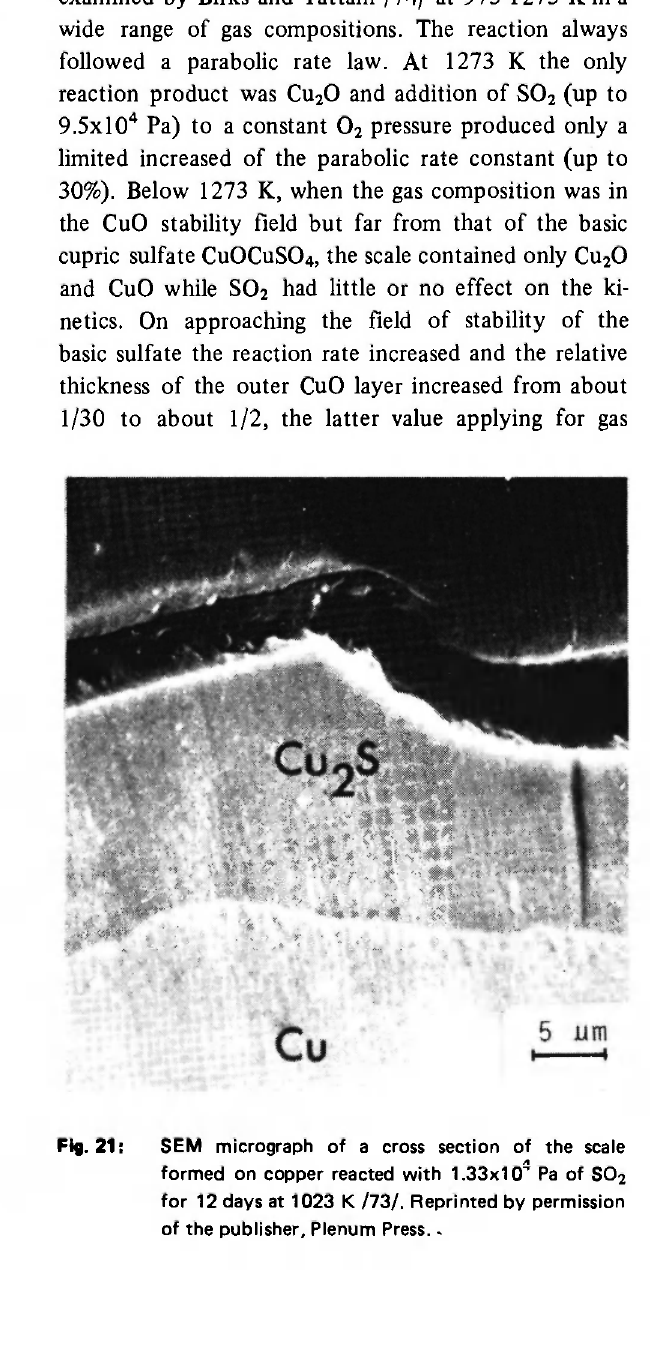
SEM micrograph of a cross section of the scale formed on copper reacted with 1.33x10 Pa of S0 2 for 12 days at 1023 Κ /73/. Reprinted by permission of the publisher. Plenum Press.